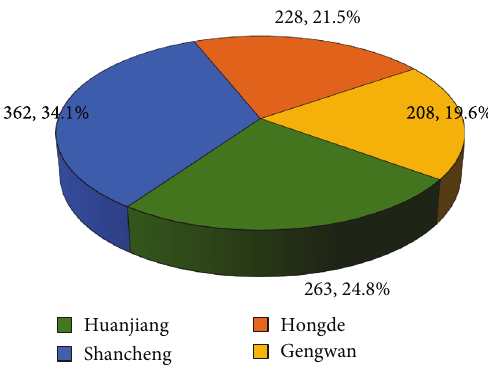
Figure 1: Number/proportion of scaling wells in di ff erent operation